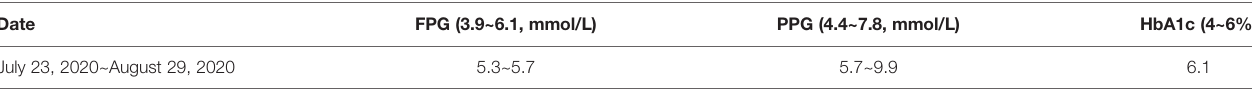
TABLE 8 | Fluctuations of self-monitoring blood glucose (SMBG) and HbA1c during follow-up analysis.